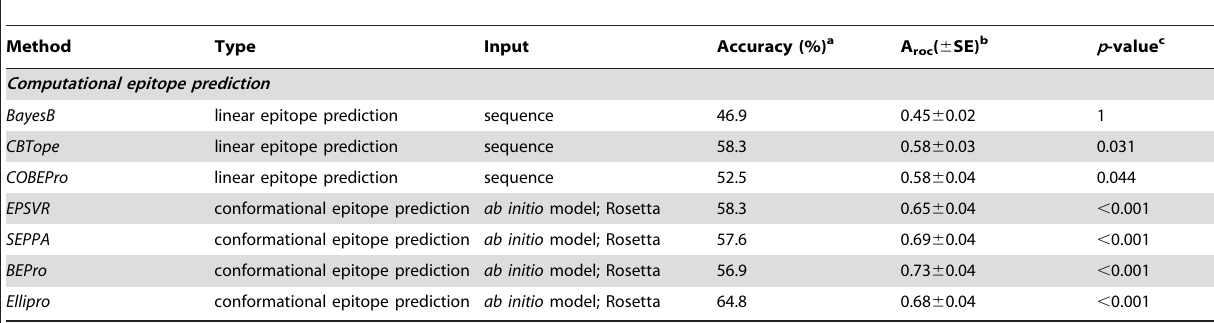
Table 2. B-cell epitope prediction using second generation